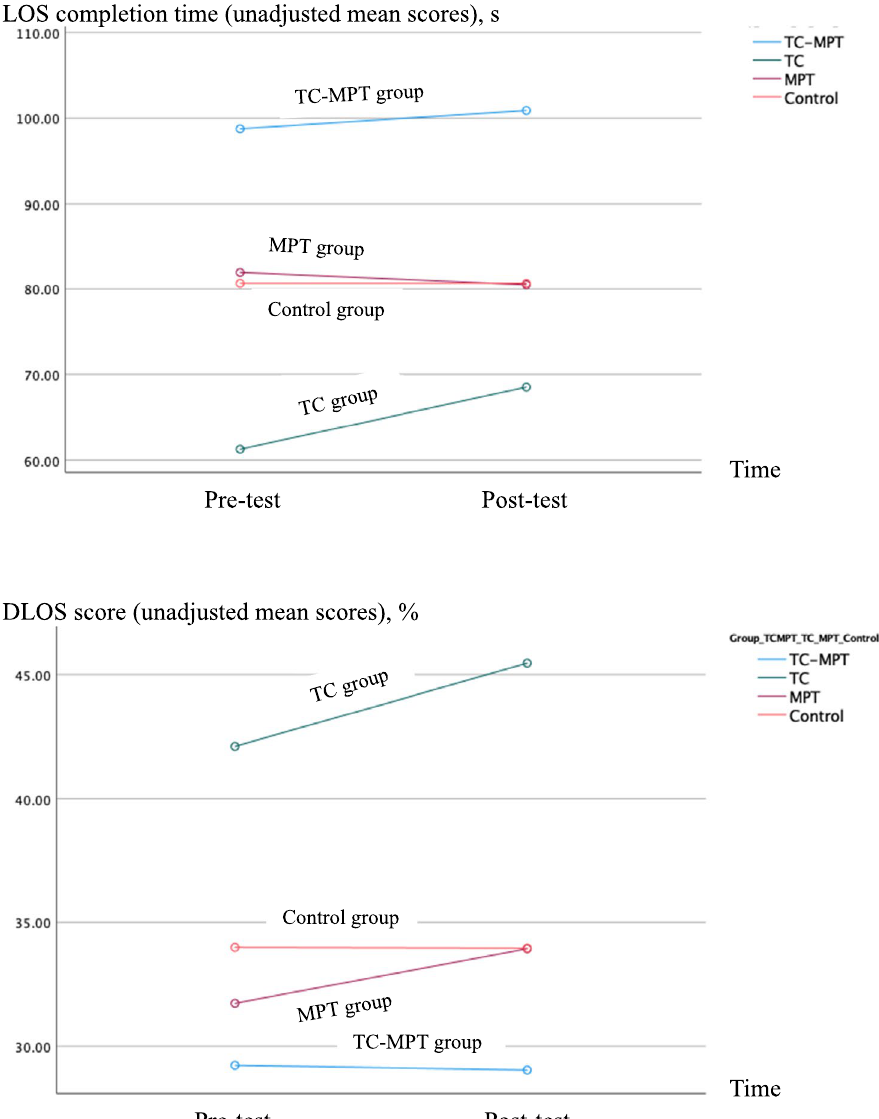
LOS = limits of stability, DLOS = dynamic limits of stability